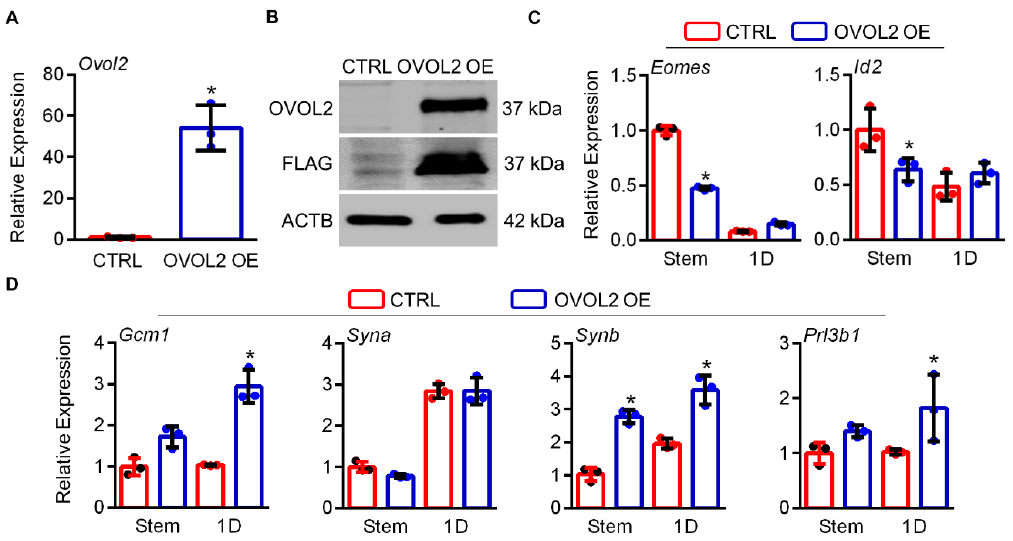
Figure 4. Ectopic expression of OVOL2 stimulates precocious differentiation of mouse TS cells. ( A ) Quantitative RT-PCR to detect Ovol2 expression in mouse TS cells transfected with either an empty vector (CTRL) or a plasmid encoding OVOL2 fused to a C-terminal FLAG tag (OVOL2 OE). ( B ) Western blot analysis to detect OVOL2 and FLAG in CTRL and OVOL2 OE mouse TS cells.